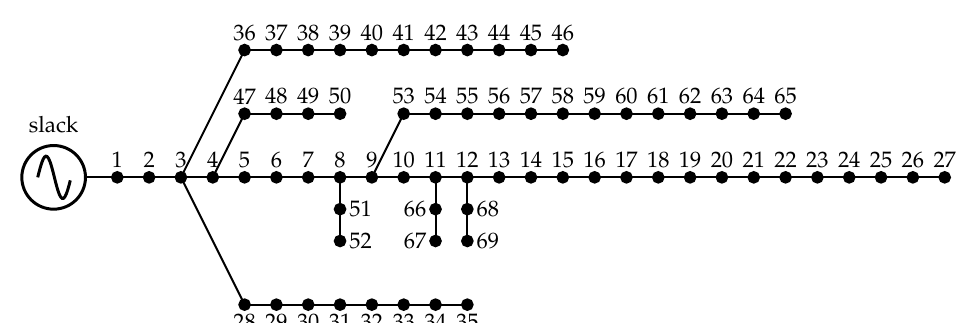
Figure 3. IEEE radial 69-node test system.